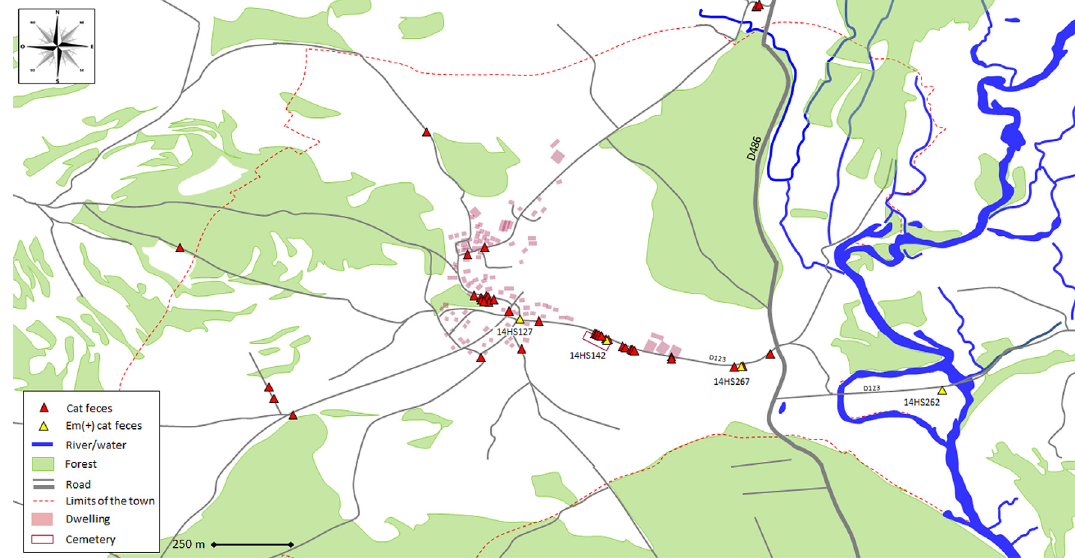
Figure 1. Map showing locations of cat feces, identified by host fecal PCR test and tested for E. multilocularis DNA presence by Em-qPCR in a rural town in France ((47 (cid:3) 35 0 27 00 N, 6 (cid:3) 24 0 56 00